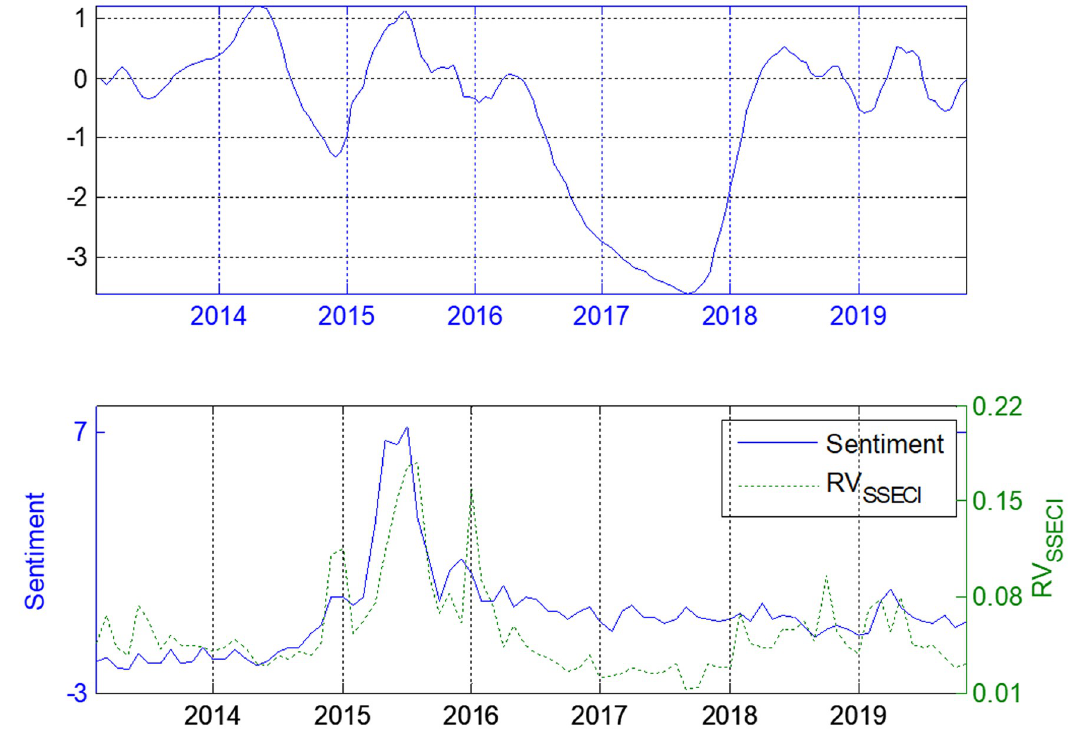
Fig 4. Lead-lag structure for investor sentiment and SSE Composite